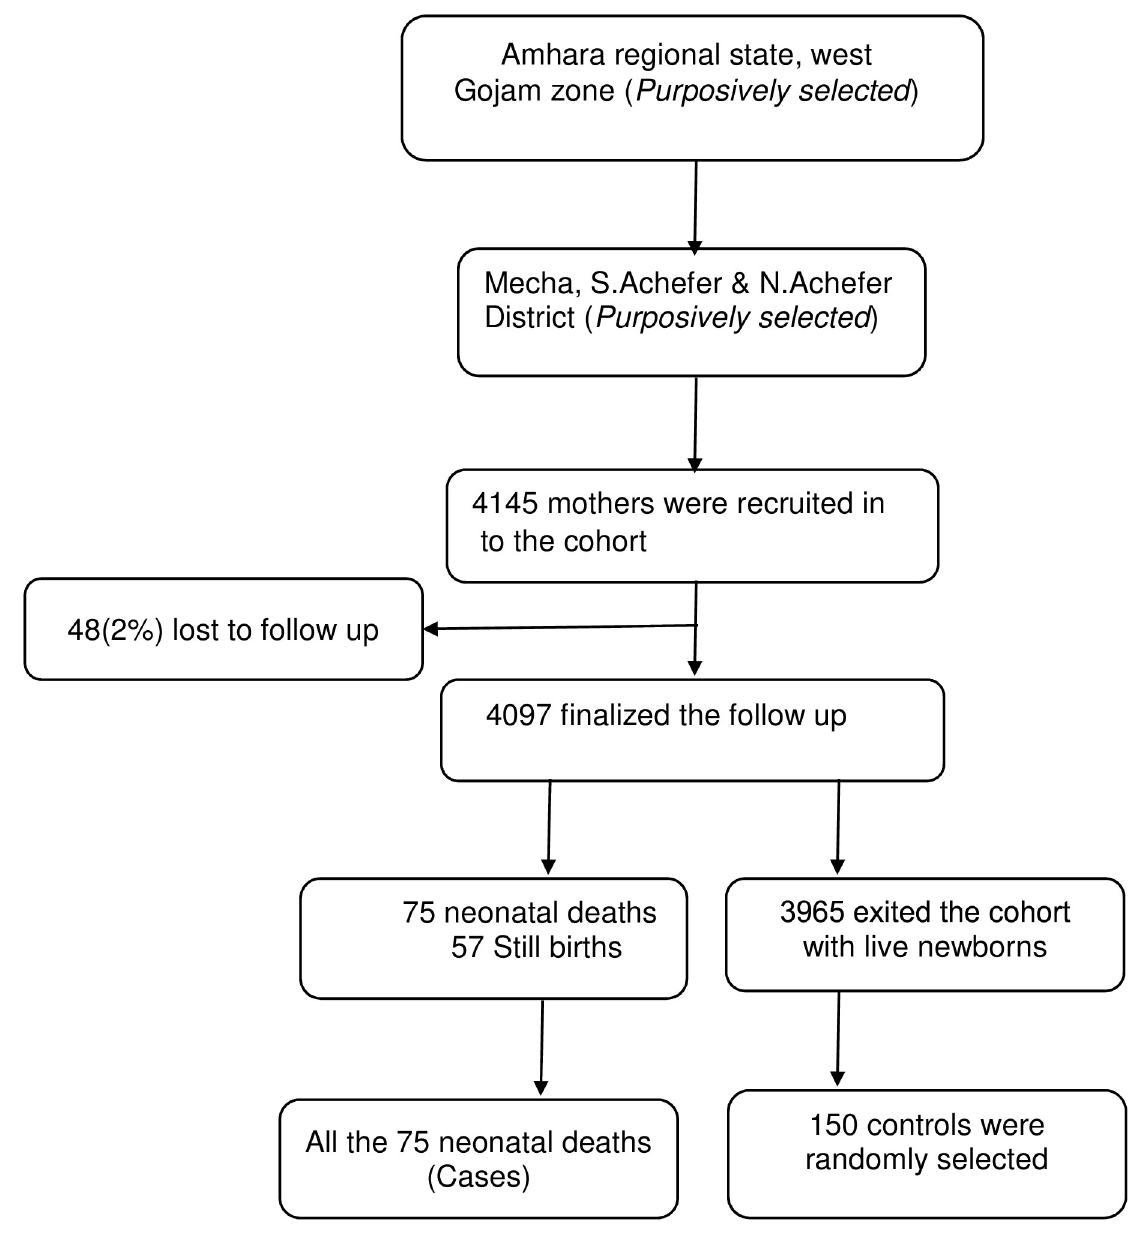
Fig 1. Sample selection